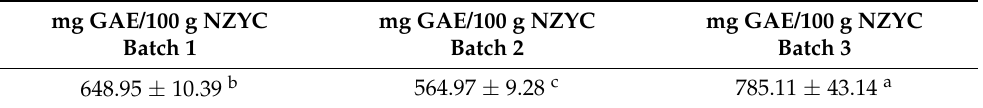
Table 4. Total phenolic content of NZYC in gallic acid equivalents (GAE) as determined by the Folin-Ciocalteau assay ( n =